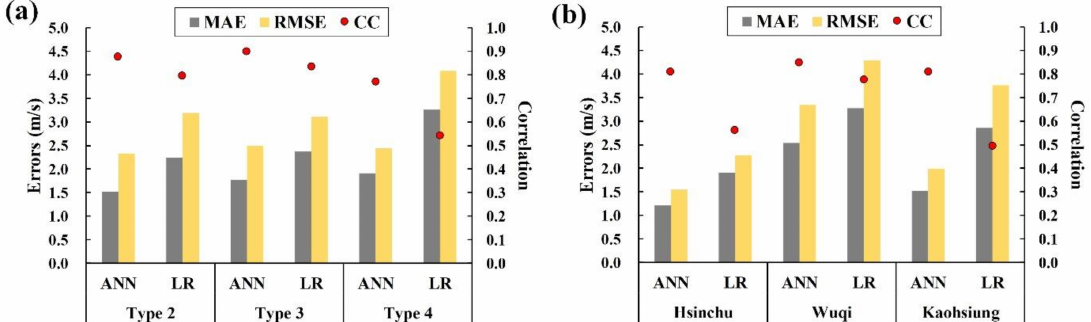
Figure 3. The overall performance of indices at an 1-h lead time: ( a ) same track disregarding prediction locations; ( b ) same prediction location disregarding tracks.